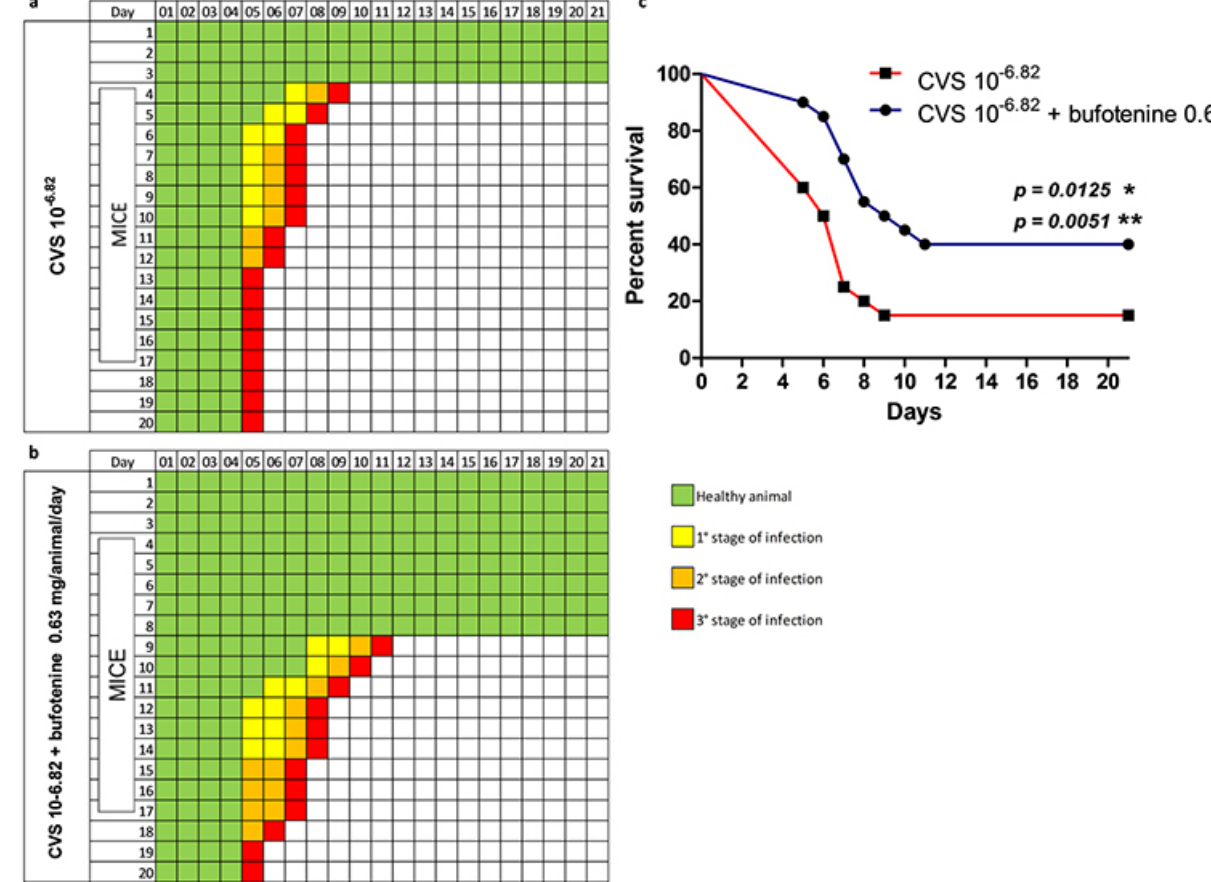
) and treated with bufotenine 0.63 mg/animal/day. 50